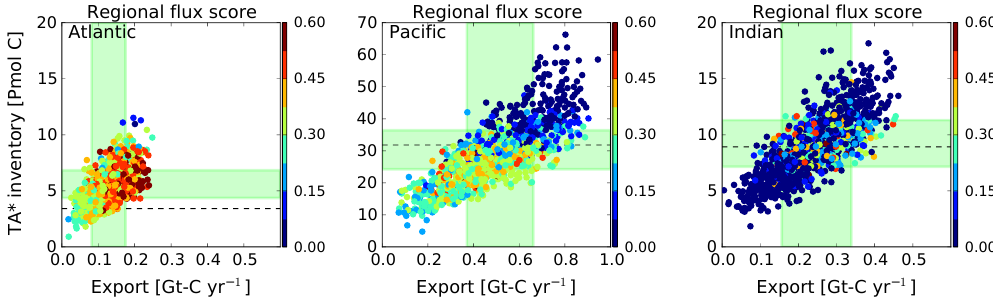
Figure A6. As Fig. 9 but coloured according to model skill with respect to the sediment trap database evaluated by basin. This target variable constrains export and dissolution to wider ranges (yellow to red colours) as compared to the TA ∗ target (light green shading). Generally, high skill scores with respect to regional, sediment-corrected TA ∗ are also associated with high skill scores with respect to regional fluxes. Only few models are in good agreement with the few flux measurements in the Indian